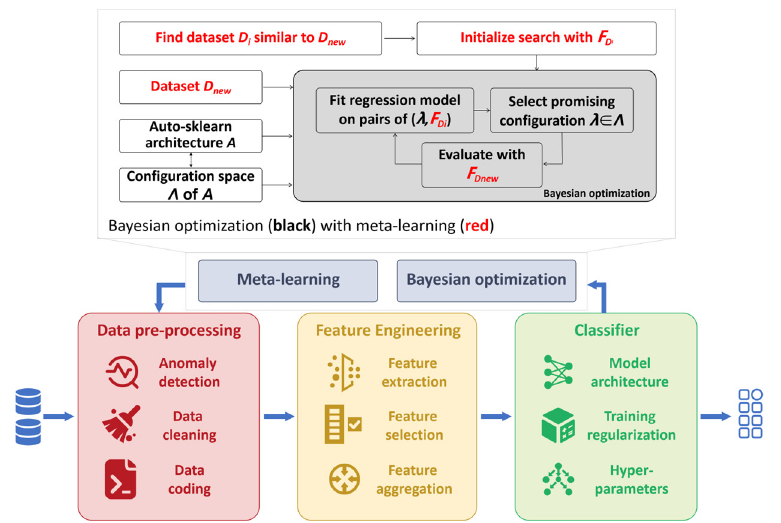
Figure 7. Flow chart for pipeline-based AutoML combined with meta-learning and Bayesian optimization.